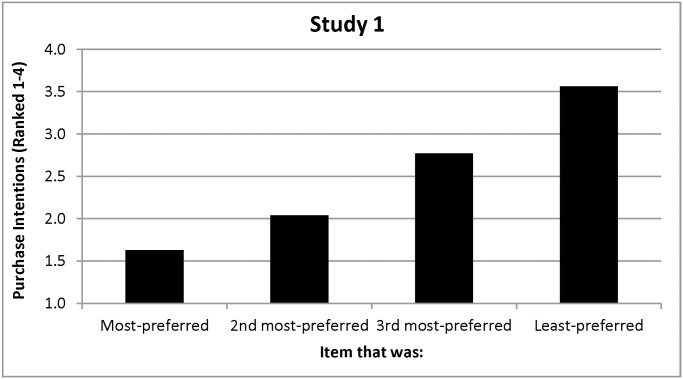
Purchase Intentions as a Function of Preferences in Study 1.